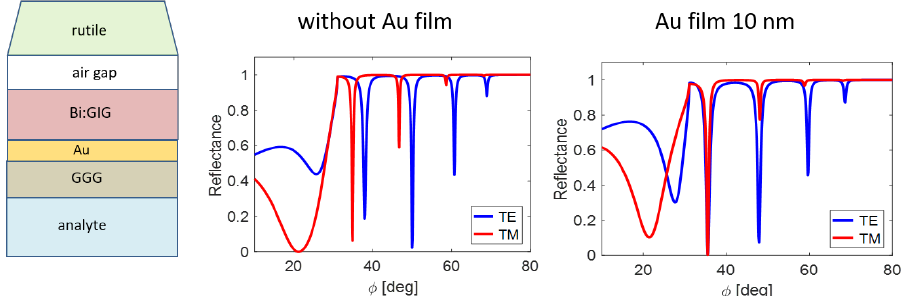
Figure 3. Angular shift of the TE resonance states due the Au film inserting ( n = 0.1838 − 3.4310i [18]) below the waveguide layer (air gap 100 nm, Bi:GIG 520 nm).